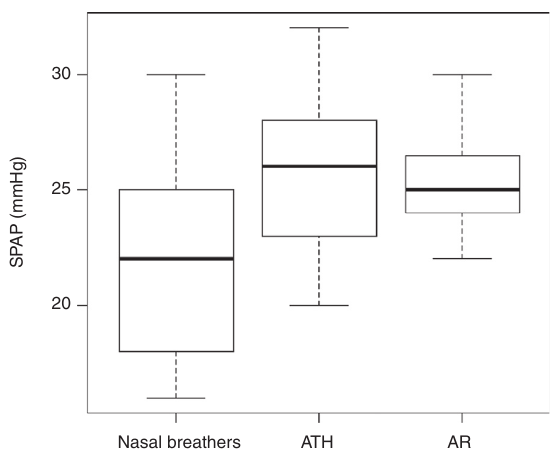
Box plot graph showing the association between the SPAP in the MB and NB groups. positive skin test was detected in 18 (35.3%) patients with ATH (Table